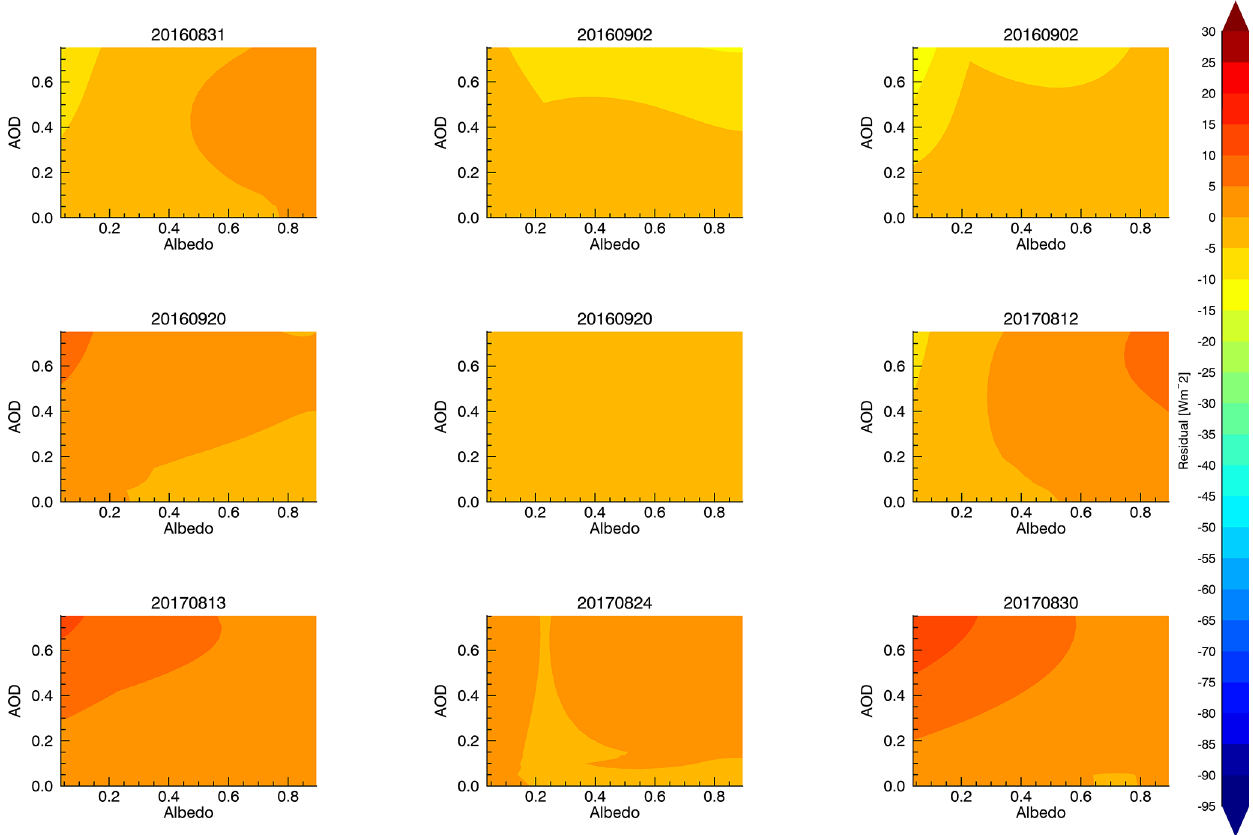
Figure D2. Residual plots of directly calculated DARE (RTM output) and predicted broadband DARE values using PX DARE at a fixed SZA (20 ◦